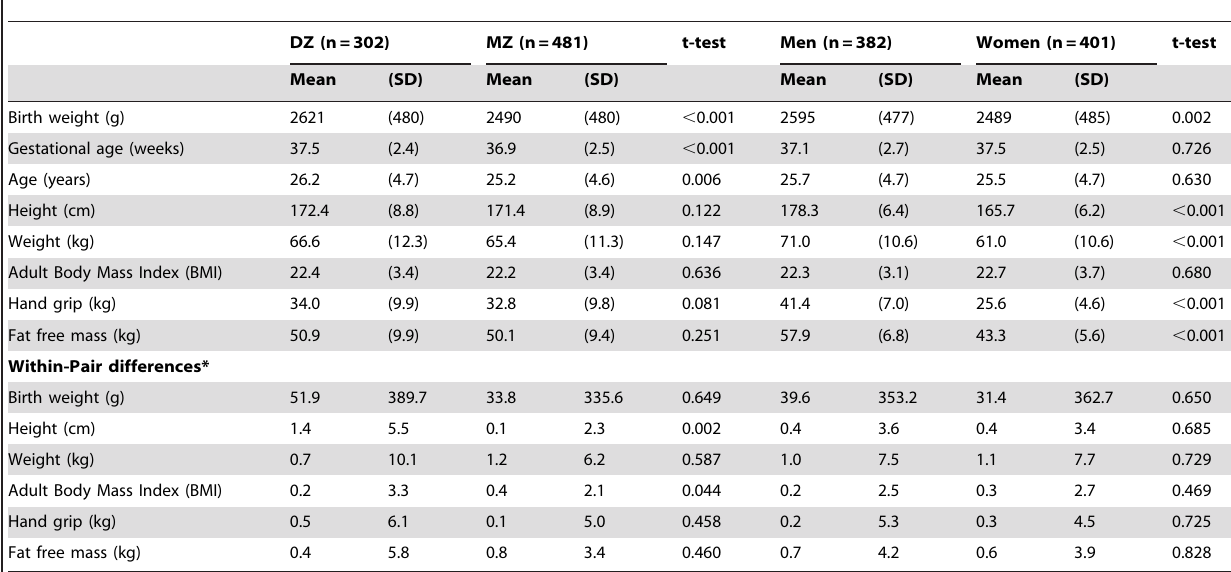
Table 1. Descriptive statistics of participants stratified by zygosity and